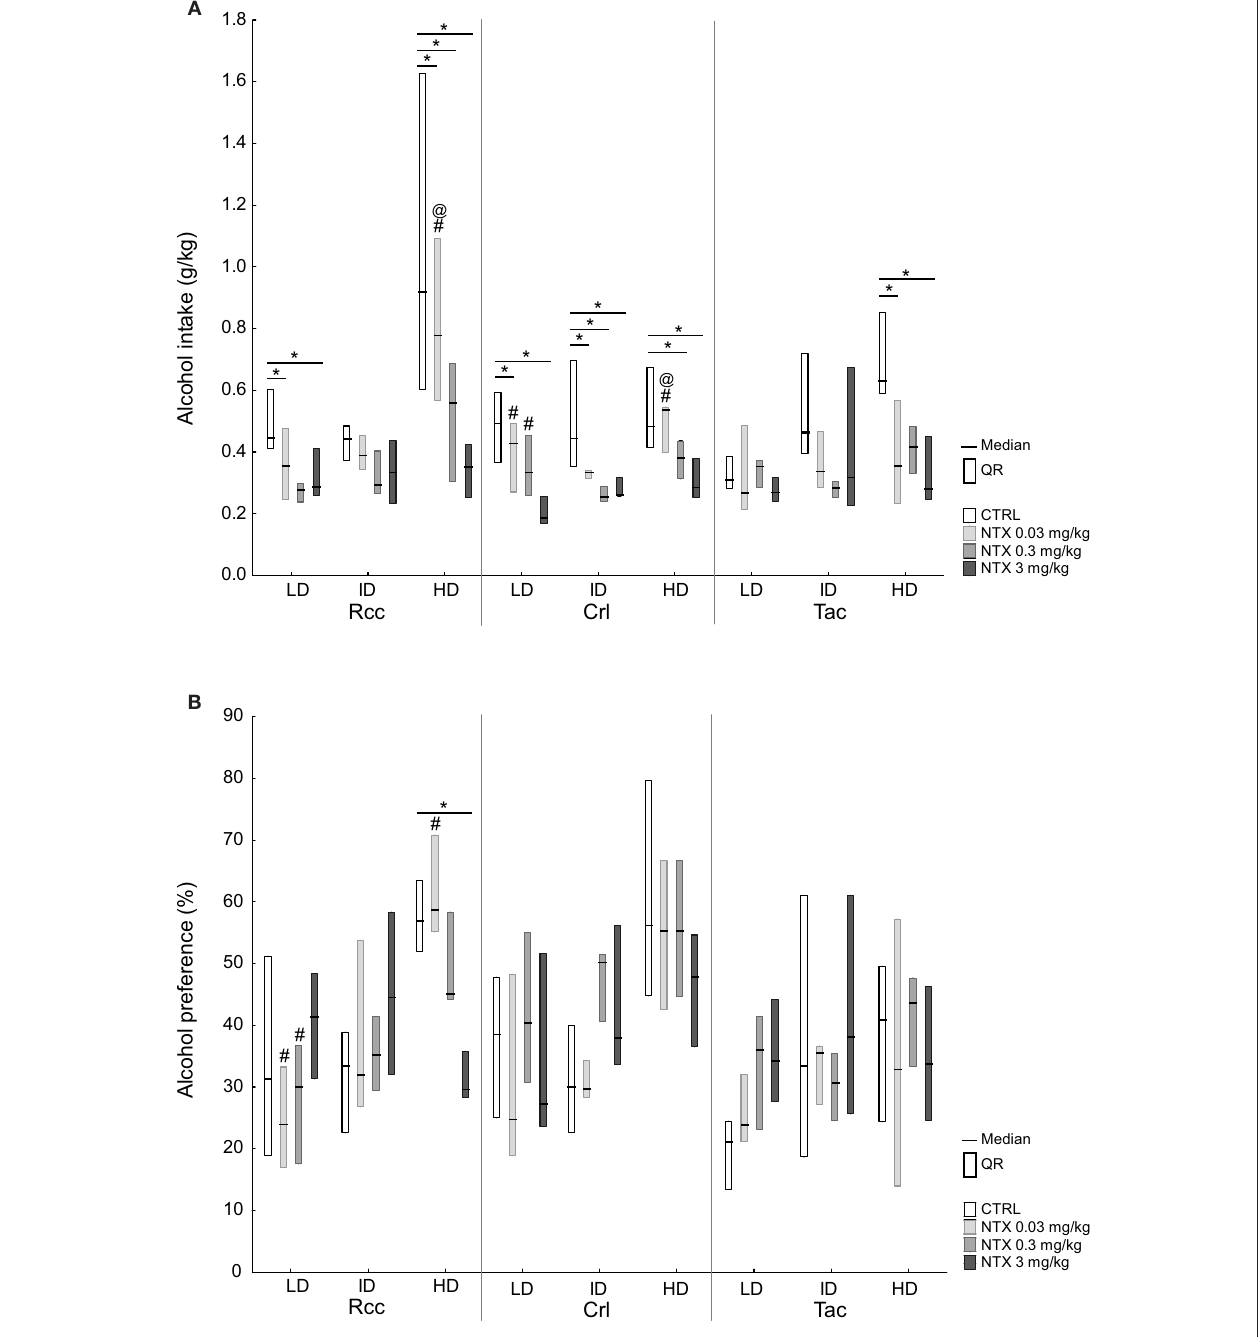
FIGURE 6 | Voluntary alcohol intake (A) and preference (B) after treatment with saline or naltrexone (0.03, 0.3, or 3mg/kg) administered s.c. 30min prior to alcohol access in Wistar rats from three different suppliers, i.e., RccHan TM :WI (Rcc), Crl:WI (Crl), and HanTac:WH (Tac), divided by a tertiary split into high drinkers (HD), intermediate drinkers (ID), and low drinkers (LD) based on the alcohol intake during weeks 1–6. Data are presented as median and quartile range. * p ≤ 0.05 compared to saline; @ p ≤ 0.05 compared to naltrexone at 0.3mg/kg; # p ≤ 0.05 compared to naltrexone at 3mg/kg (Wilcoxon matched pairs